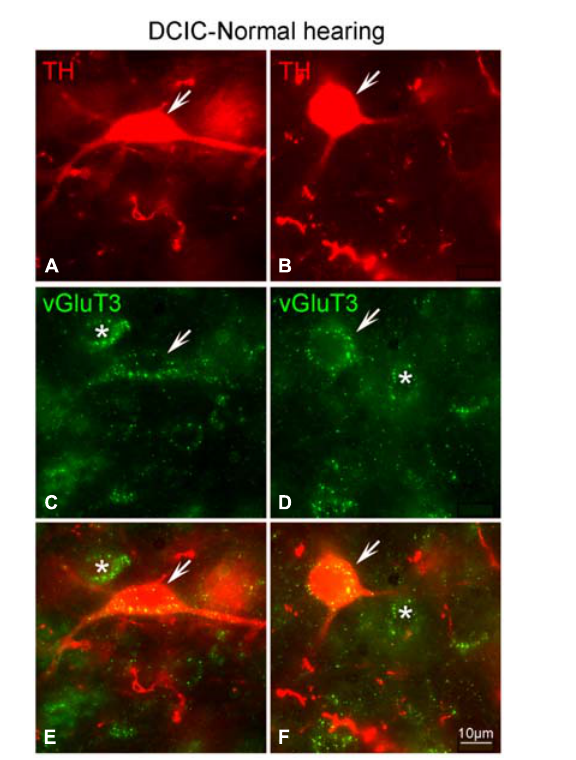
FIGURE 15 | In the DCIC VGLUT3 (green) and TH (red) are co-localized in somata and dendrites (A–F). In the DCIC double labeling for VGLUT3 and TH was primarily observed in somata and dendrites. Arrows indicate somatic and dendritic labeling for VGLUT3 and TH. The asterisks indicate neurons in the DCIC labeled only for VGLUT3. DCIC – dorsal cortex of the IC; Scale bars: 10 μ